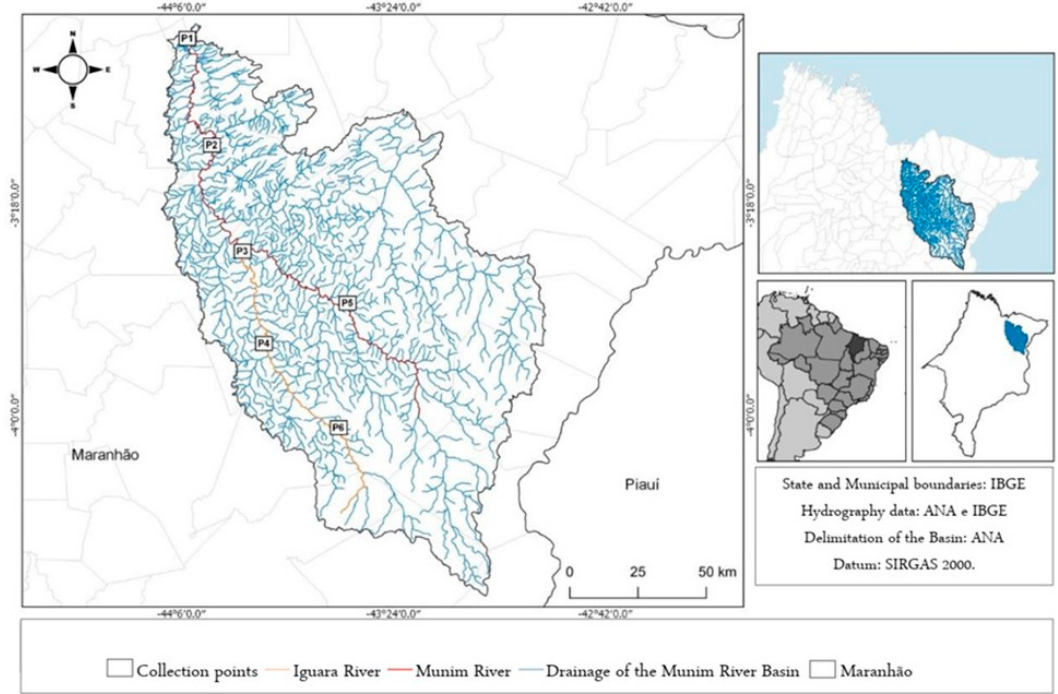
Figure 1. Study area located in the city of Nina Rodrigues, Maranhão, and collection points. Sampling was realized at points where there was a higher concentration of human activity in the municipality of Nina Rodrigues. Samples were taken at six points along the Munim and Iguará rivers: P1 (2°45 ′ 7.35 ″ S, 44° 4 ′ 49.41 ″ O), P2 (3°6 ′ 35.13 ″ S, 44°0 ′ 20.25 ″ O), and P5 (3°38 ′ 1.81 ″ S, 43°33 ′ 18.35 ″ O) collected along the Munim river; P3 (3°28 ′ 4.53 ″ S, 43°54 ′ 2.31 ″ O), P4 (3°45 ′ 54.44 ″ S, 43°49 ′ 36.12 ″ O), and P6 (4°2 ′ 49.24 ″ S, 43°35 ′ 5.11 ″ ) collected along the Iguará river. The sites were sampled four times during 2020 in the rainy (January and April) and dry (September and November) seasons (Figure 2).